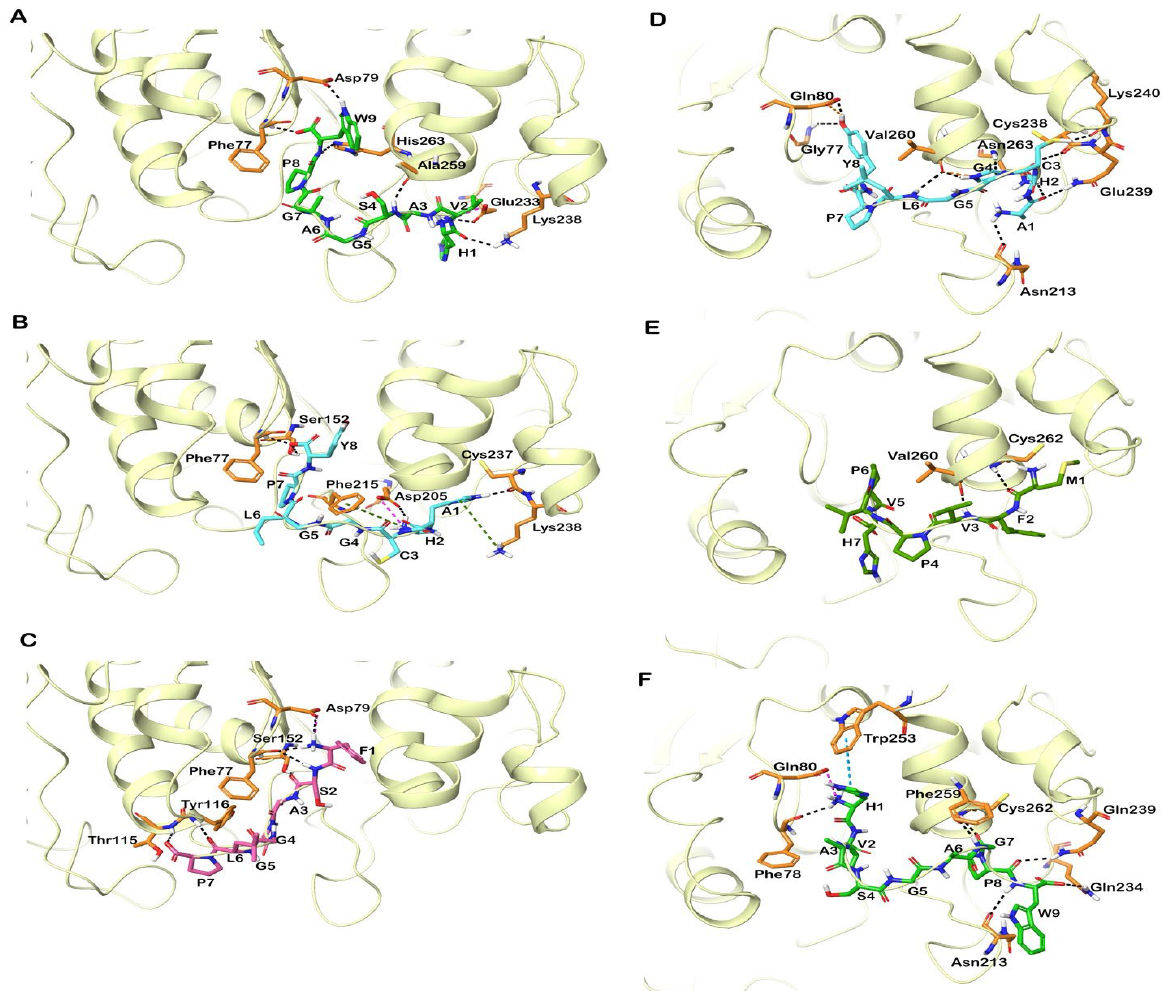
Figure 3. Docked poses of peptides in the active site of human and porcine PL (PDB ID: 1LPB, 1ETH). The protein is shown in cartoon representation and the docked peptides are shown in stick representation. The interactions of peptides ( A ) HVASGAGPW, ( B ) AHCGGLPY, and ( C ) FSAGGLP in the active site of human PL. Interactions of peptides ( D ) AHCGGLPY, ( E ) MFVPVPH and ( F ) HVASGAGPW in the active site of porcine PL. Hydrogen bonds, π - π stacking, π -cation interactions and salt bridges are represented in black-blue, green and pink dashed lines. Keyword: Pancreatic lipase (PL).